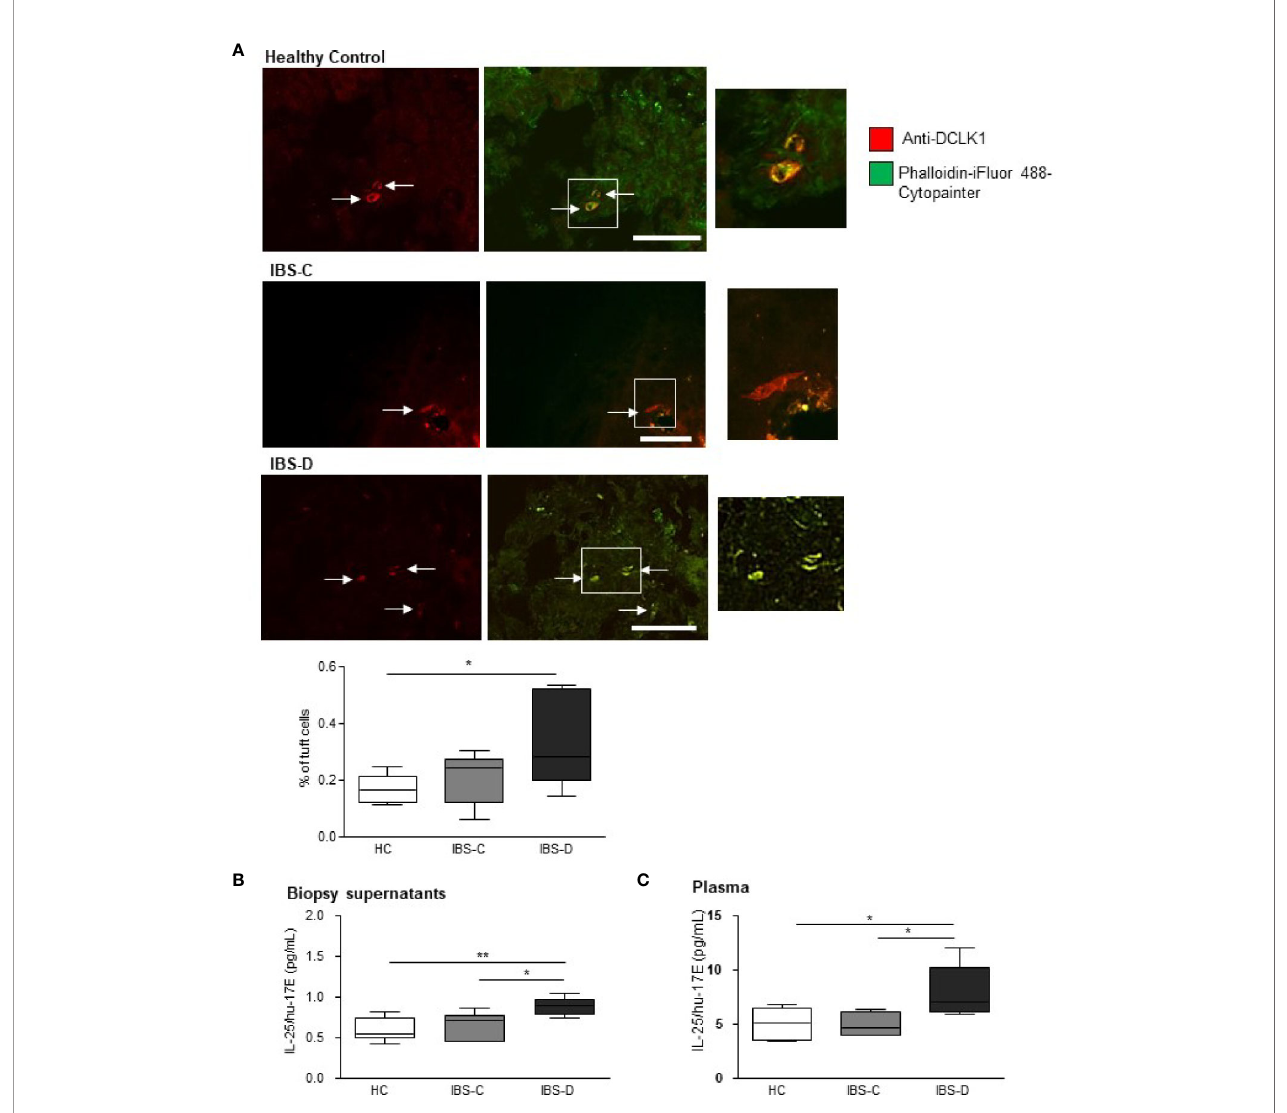
FIGURE 1 | Tuft cell density and IL-25 secretion is elevated in IBS-D colonic mucosa. (A) The representative immuno fl uorescent images and box and whisker plots of pooled data illustrate the density of DCLK1-labeled tuft cells as a percentage of the total DAPI-stained epithelial cells in mucosal biopsies from healthy patients and patients with constipation- (IBS-C) or diarrhea-predominant (IBS-D) IBS. Scalebar: 50 µm. (B) The pooled data shows that colonic biopsies and (C) plasma samples from human IBS-D patients secrete more IL-25 than other groups. * and ** indicate p <0.05 and p <0.01,